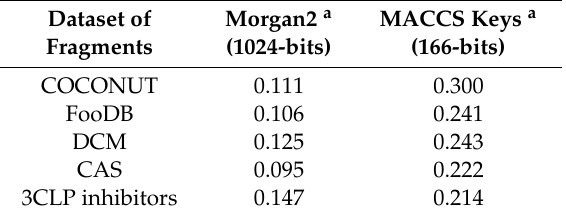
Table 5. Summary of the fingerprint-based structural diversity of the fragment datasets. Dataset